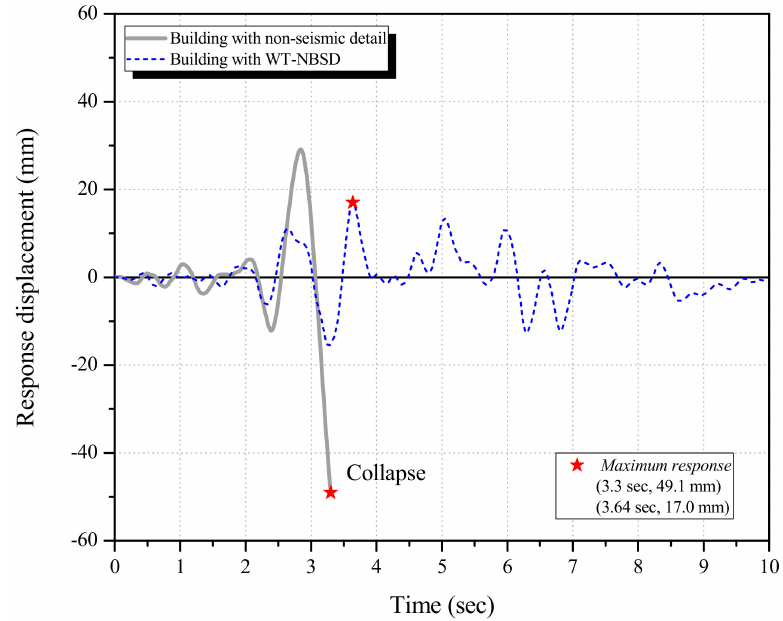
Figure 30. Time-displacement hysteresis loops of the reference building and the building retrofitted with NBSD (firsts floor).